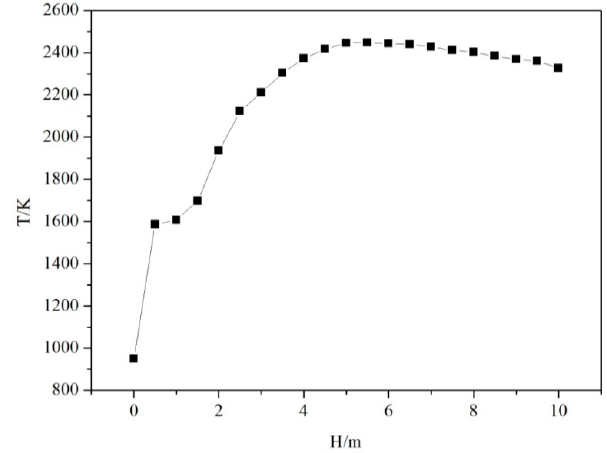
Figure 6. The average gas temperature versus the height of the reaction shaft.